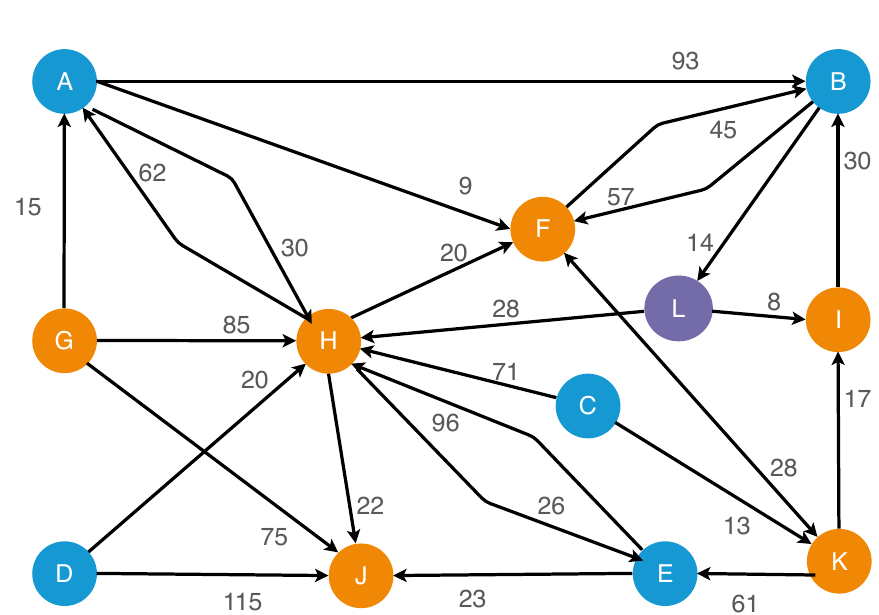
Figure 1. Example of a community-based citation graph containing references between conferences at time t from conference universe U = f A; B; C; D; E; F; G; H; I; J; K; L g , where each vertex symbolizes conference, each edge symbolizes reference, with the number of citations indicated above the edge, and colors indicate different conference